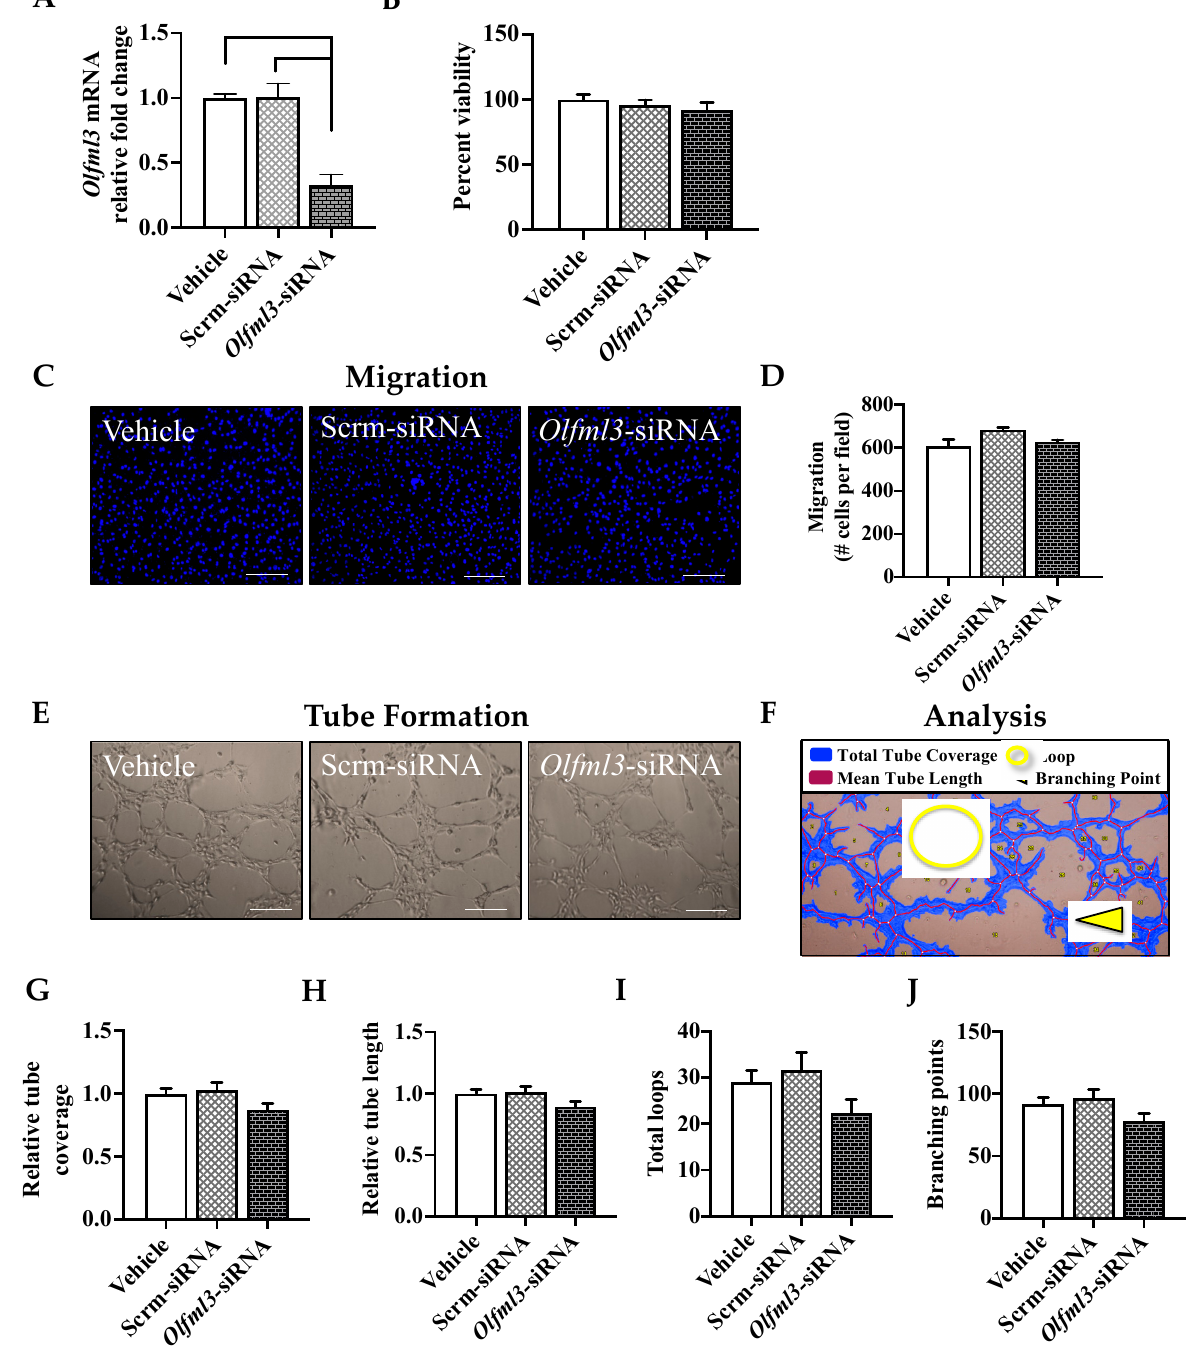
Figure 1. Reduced endogenous Olfml3 mRNA levels do not affect primary mouse brain endothelial cell (EC) angiogenesis . ( A ) Transfection with siRNA targeting Olfml3 ( Olfml3 -siRNA) reduced EC Olfml3 mRNA expression by >60% relative to vehicle-and non-targeting siRNA-treated (scrm-siRNA) ECs. ( B ) Reduced mRNA levels of Olfml3 did not alter EC viability ( p = 0.7773). ( C ) Representative images of primary mouse brain EC migration following vehicle treatment and transfection with scrm-siRNA and Olfml3 -siRNA; scale bars 50 μ m. ( D ) Reduced mRNA levels of Olfml3 did not alter EC migration ( p = 0.1154). ( E ) Representative images of primary mouse brain EC differentiation across conditions; scale bars 50 μ m. ( F ) Representative image of Wimasis analysis of key parameters of EC differentiation. EC differentiation was not altered by reduced Olfml3 mRNA levels, as determined by ( G ) relative tube coverage ( p = 0.1130), ( H ) relative tube length ( p = 0.1431), ( I ) total loops ( p = 0.1687), and ( J ) branching points ( p = 0.1788). Comparisons based on one-way ANOVA with Tukey’s multiple comparisons test; bars represent group mean with standard error of the mean (SEM). 2.2. Exogenous OLFML3 Promotes Primary Mouse Brain EC Viability, Migration, and Proliferation We next sought to determine the effect of exogenous OLFML3 on EC angiogenesis. To directly evaluate this, we treated primary mouse brain ECs with recombinant human OLFML3 (rhOLFML3; 10 ng/mL, 48 h). Exposure to rhOLFML3 nearly doubled EC viability relative to vehicle-treated ECs ( p = 0.0001) (Figure 2A). Migration was also increased following rhOLFML3 treatment ( p = 0.02) (Figure 2B,C). Moreover, multiple parameters of differentiation were increased by rhOLFML3 exposure. Relative tube coverage ( p = 0.0346) (Figure 2E) and branching points ( p = 0.0410) (Figure 2H) were both increased following exposure to rhOLFML3. Neither relative tube length ( p = 0.1381) (Figure 2F), nor total loops ( p = 0.2147) (Figure 2G) were altered by rhOLFML3 treatment. These findings support our hypothesis that OLFML3 is sufficient to promote angiogenesis in brain microvascular ECs.